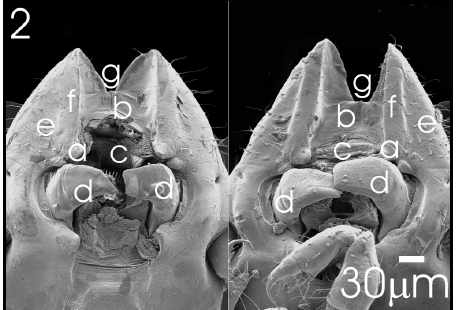
Fig. 2. The ventral surface of the head showing the structures of the preantennal regions (a) ventral cari- na, (b) pulvinus, (c)labrum, (d) mandibles, (e) clypeus, (f) thickened rim of the clypeus (g) invagi- nation of the forehead, in both the male (left) and female specimens of Damalinia crenelata .